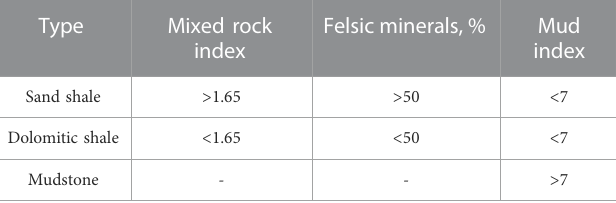
TABLE 1 Classi fi cation of shale oil reservoirs in Fengcheng Formation.